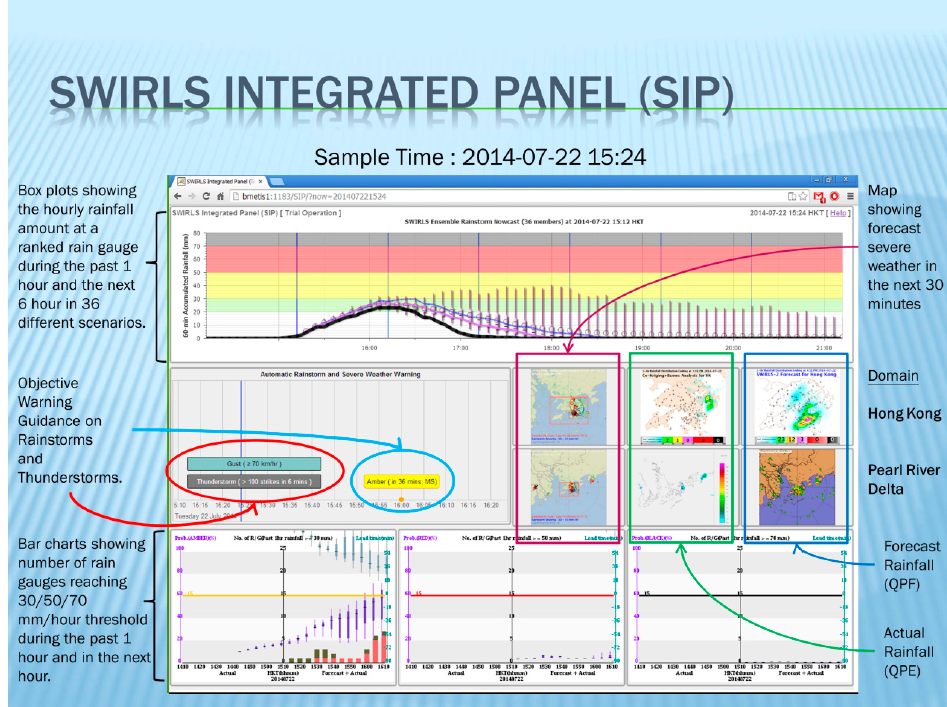
Figure 3. An integrated product of SWIRLS to support rainstorm warning system.